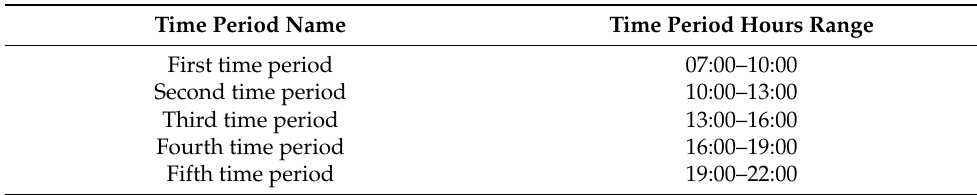
Table 4. Time period range